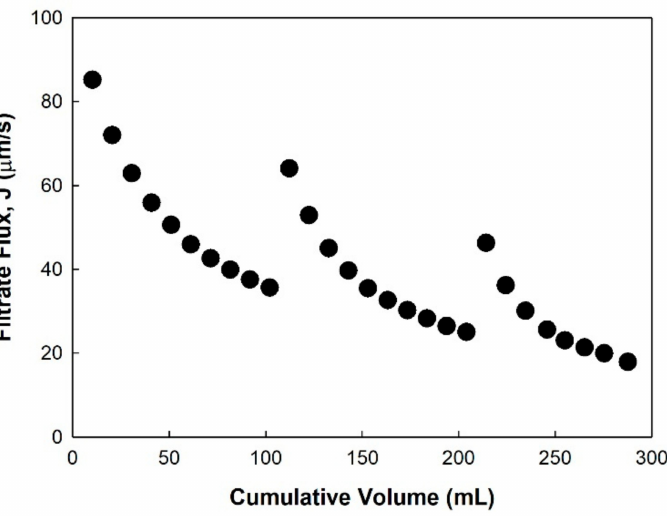
Figure 7. Filtrate flux behavior of pressure release during ultrafiltration using the normal flow filtration system with 20 mM histidine at pH 6 with 100 mM sucrose solution. The applied pressure was 100 kPa and the stirring speed was 800 rpm. Pressure release was carried out for 10 min at approximately 100 and 200 mL of the cumulative